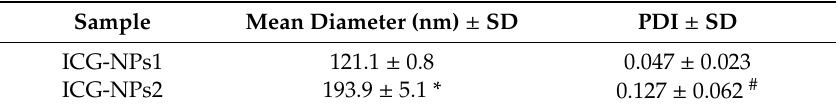
Table 1. Particle size and PDI (polydispersity index) of ICG-NPs1 and ICG-NPs2. Results are expressed as mean ± SD.